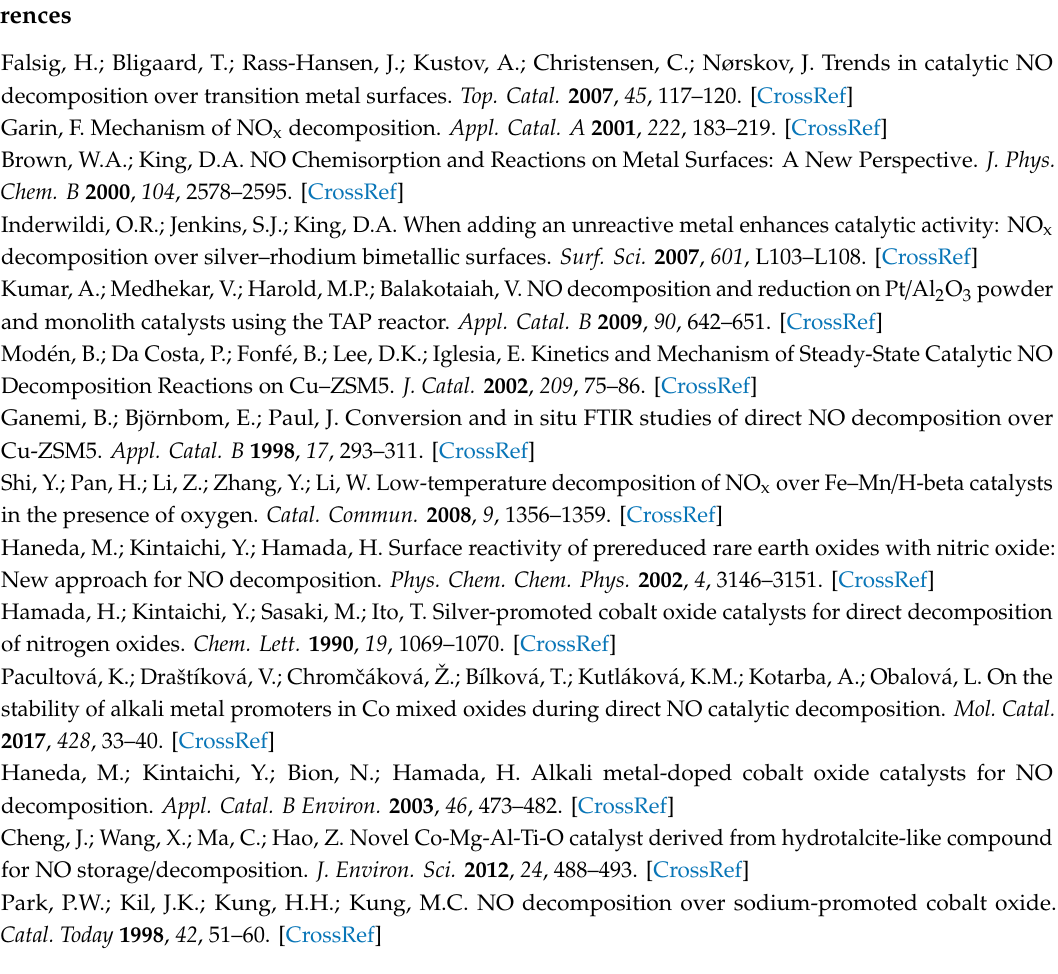
Figure S1: XRD results for samples K(II) / y / 4., Figure S2: XRD results for samples K( x ) / 600 / z ., Figure S3: XRD results for samples K( x ) / 800 / z ., Figure S4: XPS results., Figure S5: TPR H 2 —e ff ect of potassium amount., Figure S6: T max (from TPR H 2) dependence on K amount, Figure S7: TPR H 2 —e ff ect of calcination temperature for samples K(II) / y / 4., Figure S8: TPR H 2 —e ff ect of calcination temperature for samples K(I) / y / z ., Table S9: Work function of selected